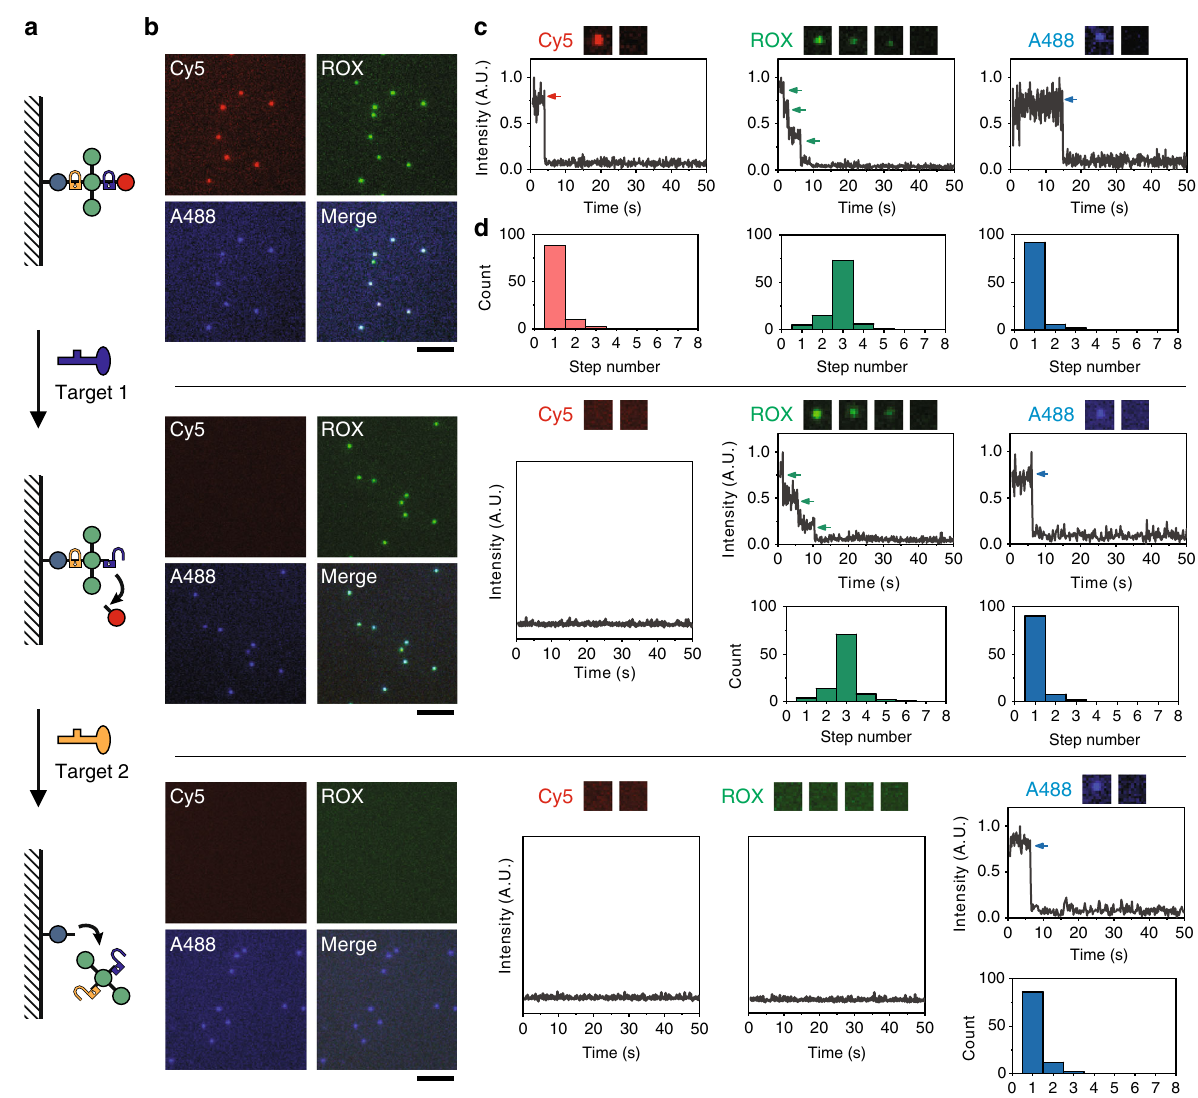
Fig. 5 Single-molecule recognition using FDF probes. a Schematic illustration of the molecule recognition strategy. b Fluorescent microscopic images of the FDF probes. Scale bar, 5 µ m. c Single-molecule fl uorescence quenching kinetics of the FDF probes in respond to different targets. d Distributions of quenching step counts ( N =